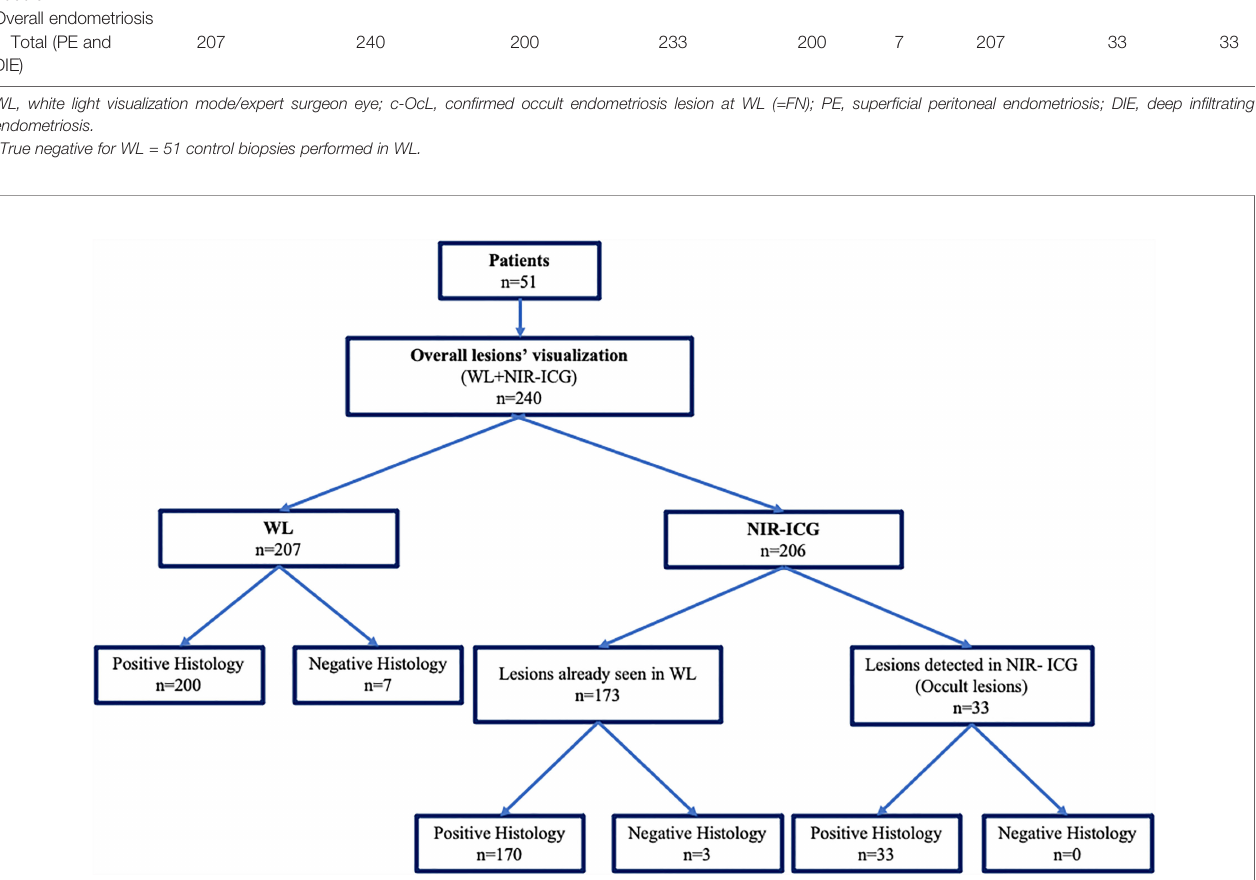
Frontiers in Oncology |